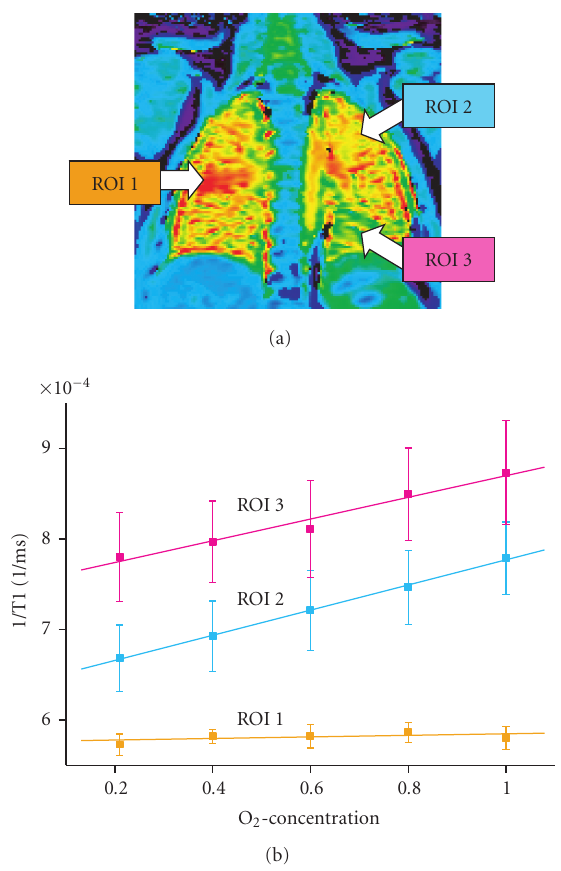
Figure 8: Oxygen transfer function (OTF) of a patient with Cystic Fibroses from Ill. 6. Healthy lung segments (ROI 2 and 3) demon- strate a linear increase in relaxivity ( = 1/T1) with increasing oxy- gen concentrations. The slope of the curve is a measurement of lung oxygen transport capacity. The diseased lung segment (ROI 1) shows no rise; there is therefore no oxygen